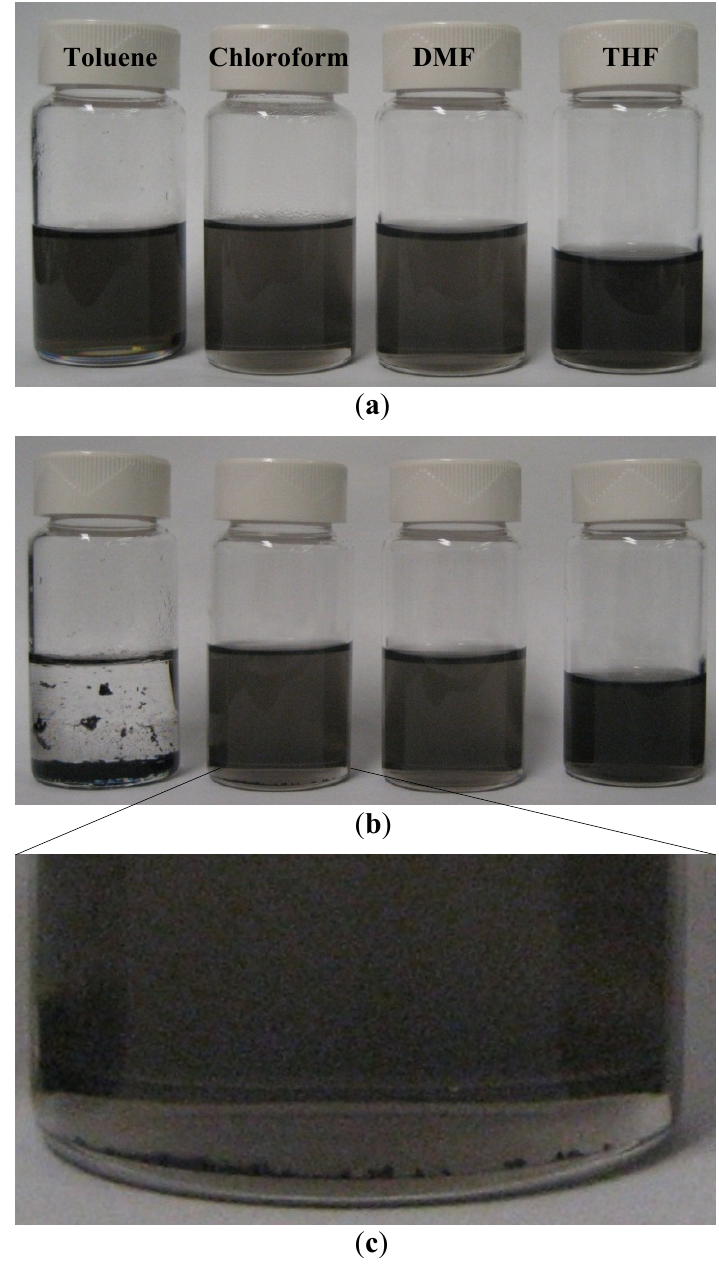
Figure 2. MWCNTs dispersed in different organic solvents via 30 min of sonication. Solutions from left to right: toluene (0.3 mg/mL MWCNTs), chloroform (0.3 mg/mL), dimethylformamide (DMF) (0.3 mg/mL), tetrahydrofuran (THF) (0.4